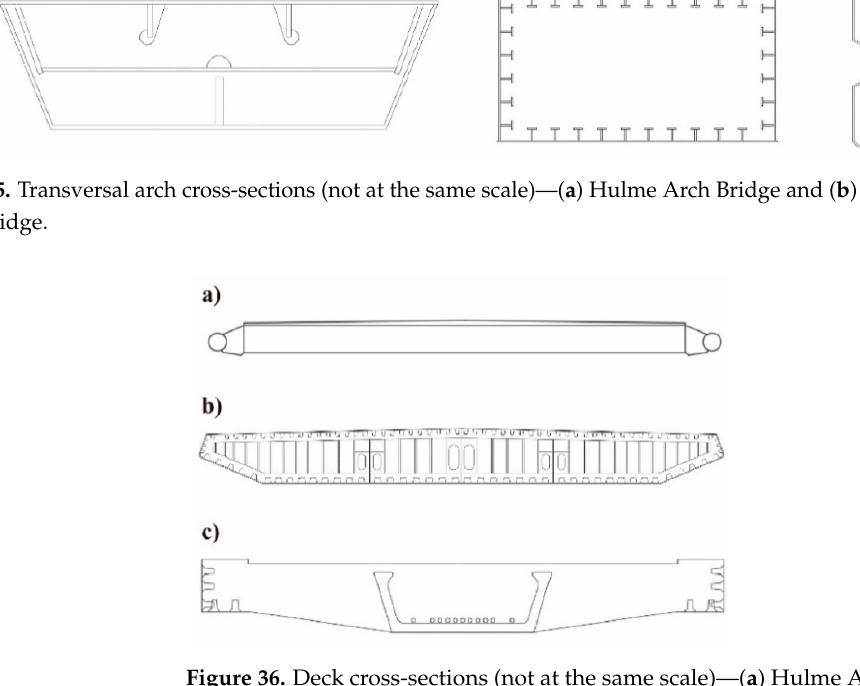
Figure 36. Deck cross-sections (not at the same scale)—( a ) Hulme Arch Bridge, ( b ) Yueniang Arch Bridge, and ( c ) AP-36 Bridge.